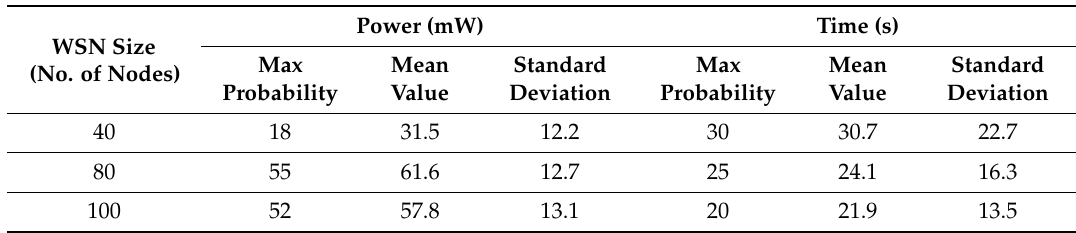
Table 1. Statistic simulation results.